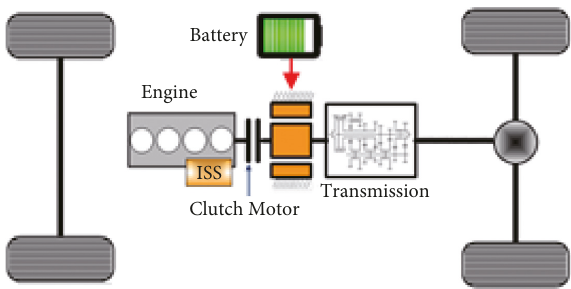
Figure 1: A certain C class plug-in hybrid system